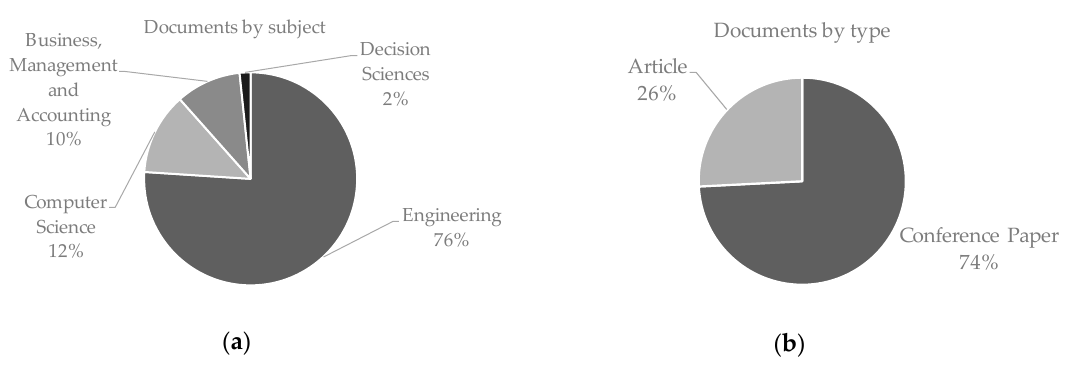
Figure 6. Documents by subject ( a ); documents by type ( b ).